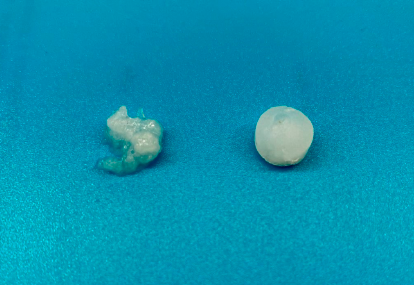
Figure 8. GG24 (on the right) and GG8 (on the left) ionotropic crosslinked hydrogels after 1 week of incubation at 37 °C in DPBS pH 7.4.